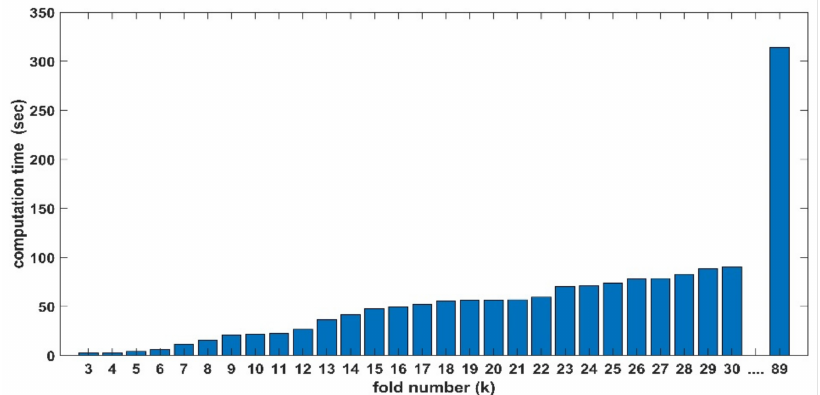
Figure 5. Comparison of the ANN’s computational times for k = 3:30 and k = 89 (leave-one-out case) values.